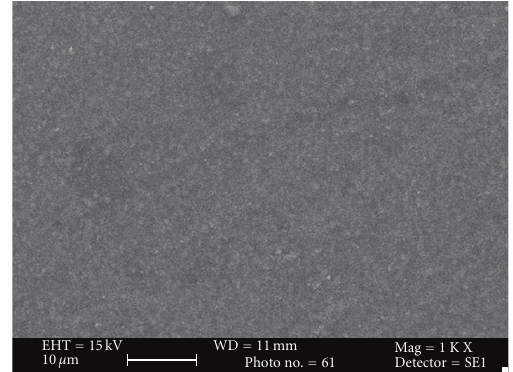
Figure 7: Photomicrograph of Admira after bleaching at 1000x.